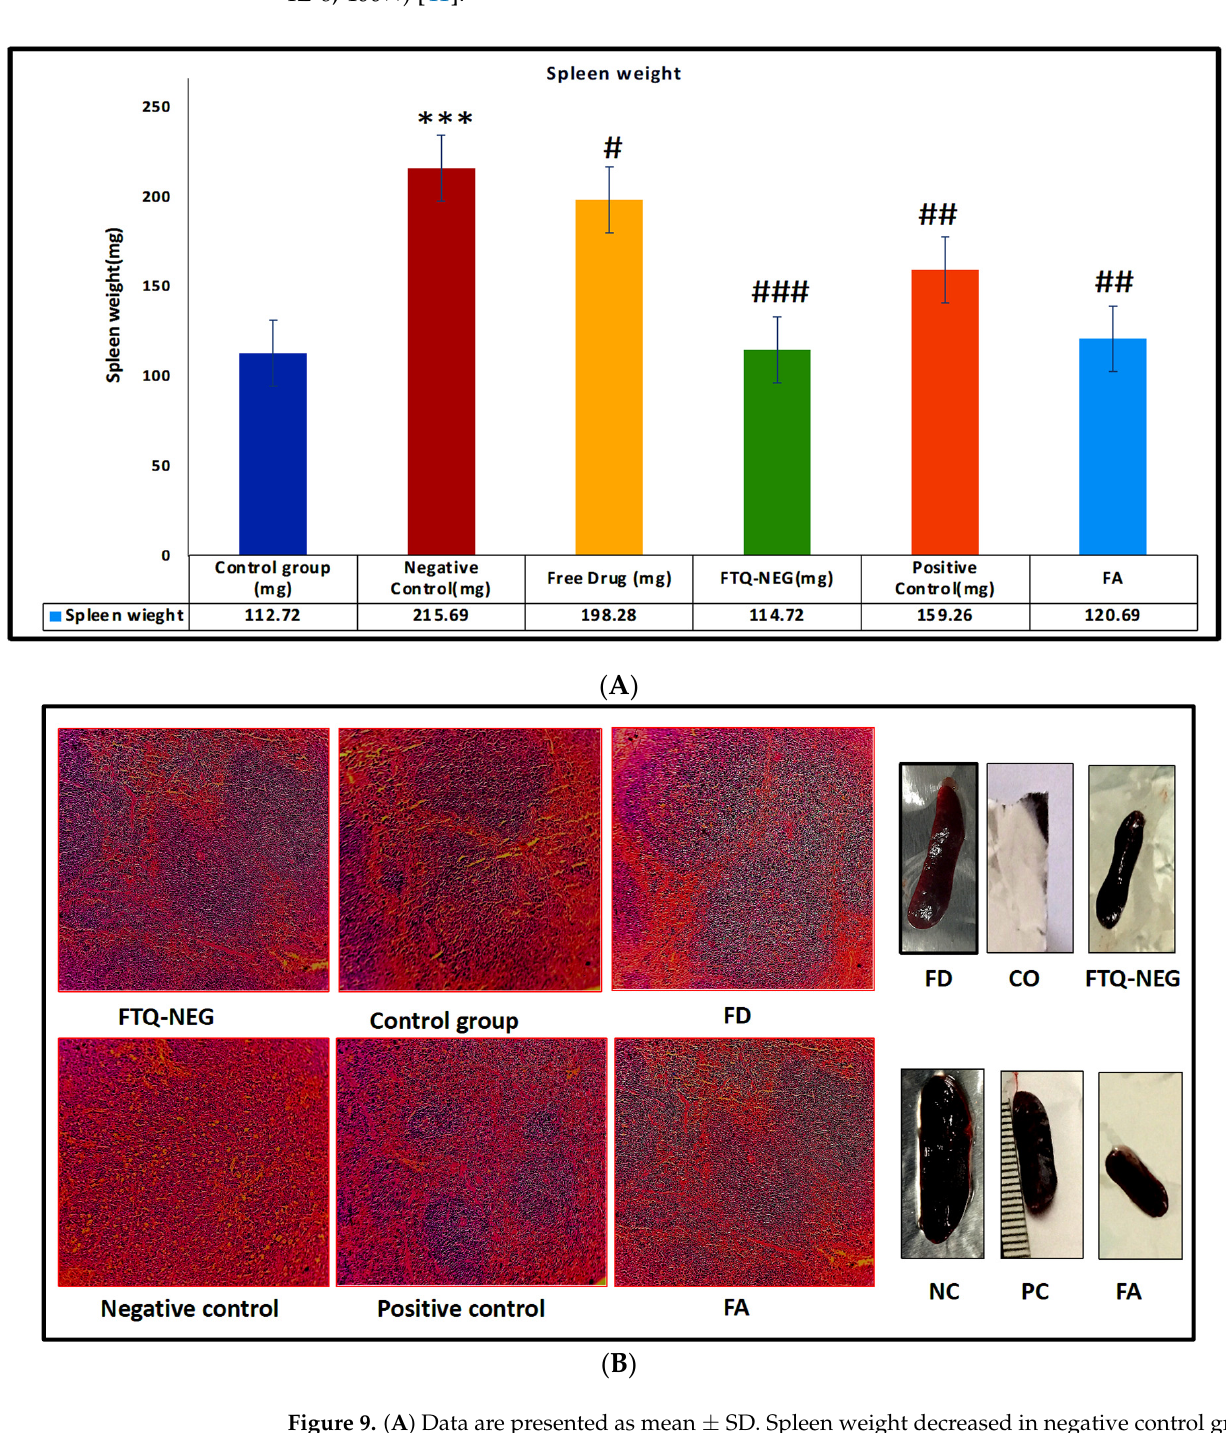
Figure 9. ( A ) Data are presented as mean ± SD. Spleen weight decreased in negative control group when compared to control group (*** p < 0.001) but increased in free drug, FTQ-NEG, positive control, and FA groups in comparison to negative control ( # p < 0.05, negative control vs free drug), ( ## p < 0.01, positive control & FA vs negative control),( ### p < 0.001 , FTQ-NEG vs negative control). ( B ) Histopathology of the spleen tissue of all the groups: Control, Negative control, FD, FTQ-NEG, Positive control, and FA